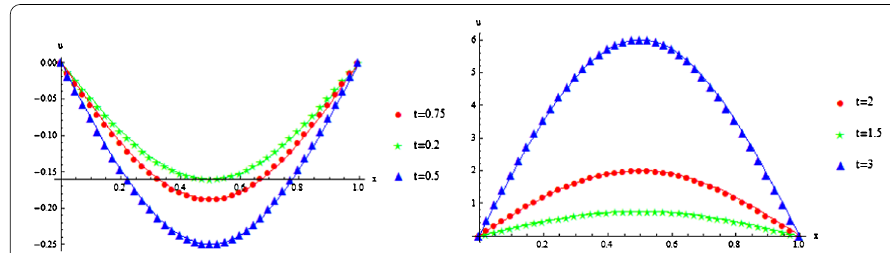
Figure 1 The comparison of exact (solid lines) and numerical solutions (stars, bullets and triangles) , (cid:2) t = 1 and γ = 1.75 at different time levels. for Example 1 when h = 1 80 100